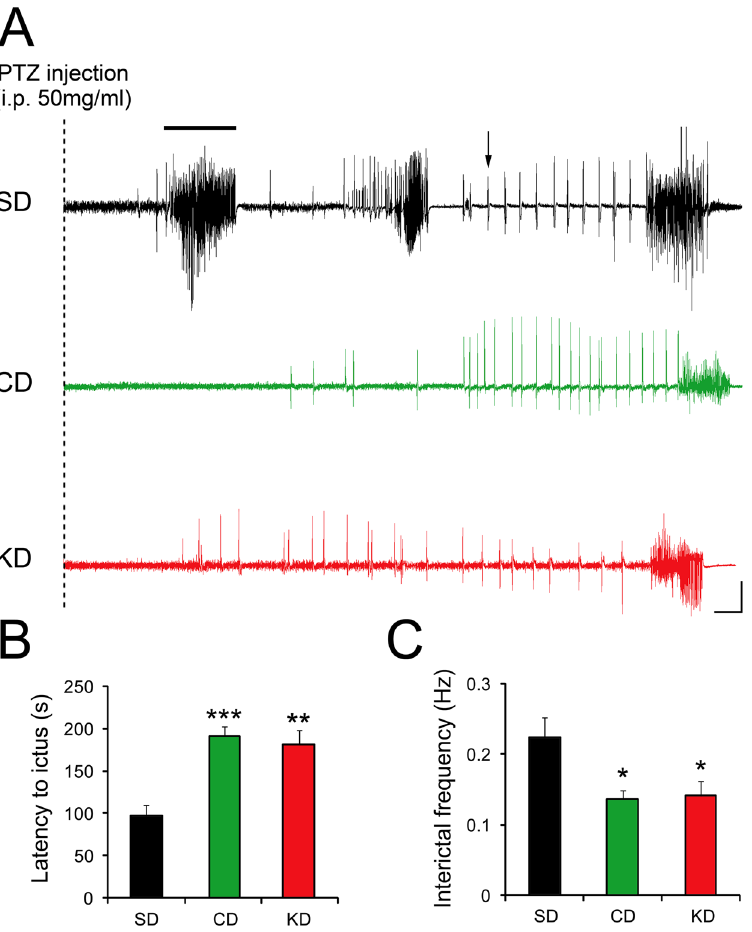
Figure 3. CD treatment decreases susceptibility to seizures. (A , B ) Injection of pentylenetetrazol (PTZ; 50 mg/ml) i.p. promptly resulted in paroxysmal events and status epilepticus in control SD fed mice. In mice receiving KD or CD treatment, the ictus (example indicated by a black bar) was triggered significantly later (SD, n = 7; KD, n = 5, p < 0.01; CD, n = 8, p < 0.001), indicating a similar protective effect of both diets. ( A,C ) Corroborating this finding, the frequency of interictal events (example shown by an arrow) was found to be significantly reduced in both KD and CD fed mice compared to SD controls (all p < 0.05). Calibration bars: 10 s, 500 µ V. * p < 0.05, ** p < 0.01, *** p <